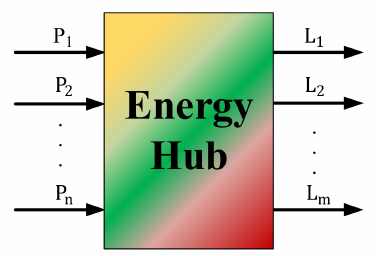
Figure 3. Description of EH based model.